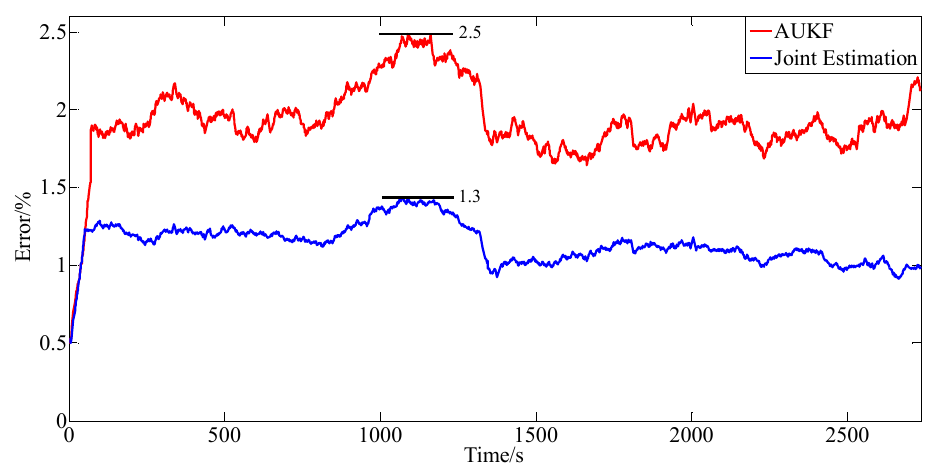
Figure 12. Comparison of the SOC estimation error.